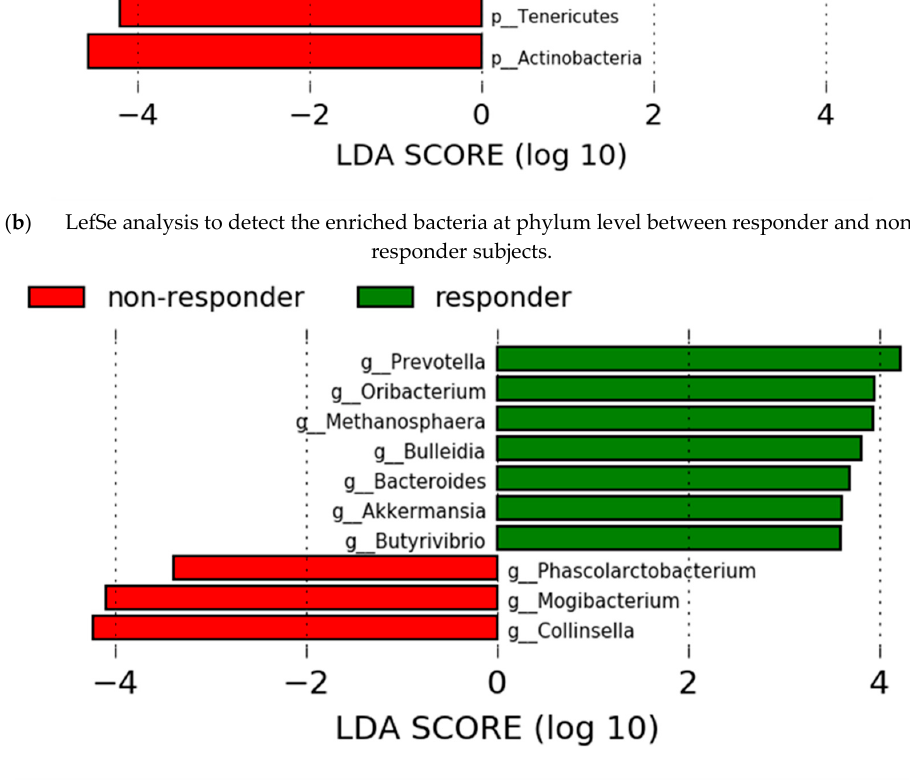
Figure 5. Gut microbiota composition analysis by response effect. ( a ) Alpha diversity by response effect group. Black boxes represent the non-responder group, and blue boxes represent the responder group. Left-top: number of observed OTUs, right-top: Shannon index, left-bottom: Fisher alpha index, and right-bottom: Simpson index. Box plots represent the median (black horizontal line), 25th, and 75th quartiles (edge of boxes) and upper and lower extremes (whiskers). Outliers are represented by a single data point. For every parameter, the global Kruskal–Wallis p -value and the p -values for every comparison between the randomized groups at different time points are presented. p -Values code: p < 0.005: ***, p < 0.01: **, p ≤ 0.05: *, and p > 0.05: ns. ( b ) LefSe analysis to detect the enriched bacteria at the phylum (p_) level between responder and non-responder subjects. ( c ) LefSe analysis to detect the enriched bacteria at the genus (g_) level between responder and non-responder subjects. Patients were considered as responders with a delta VL set point >0.5 log10